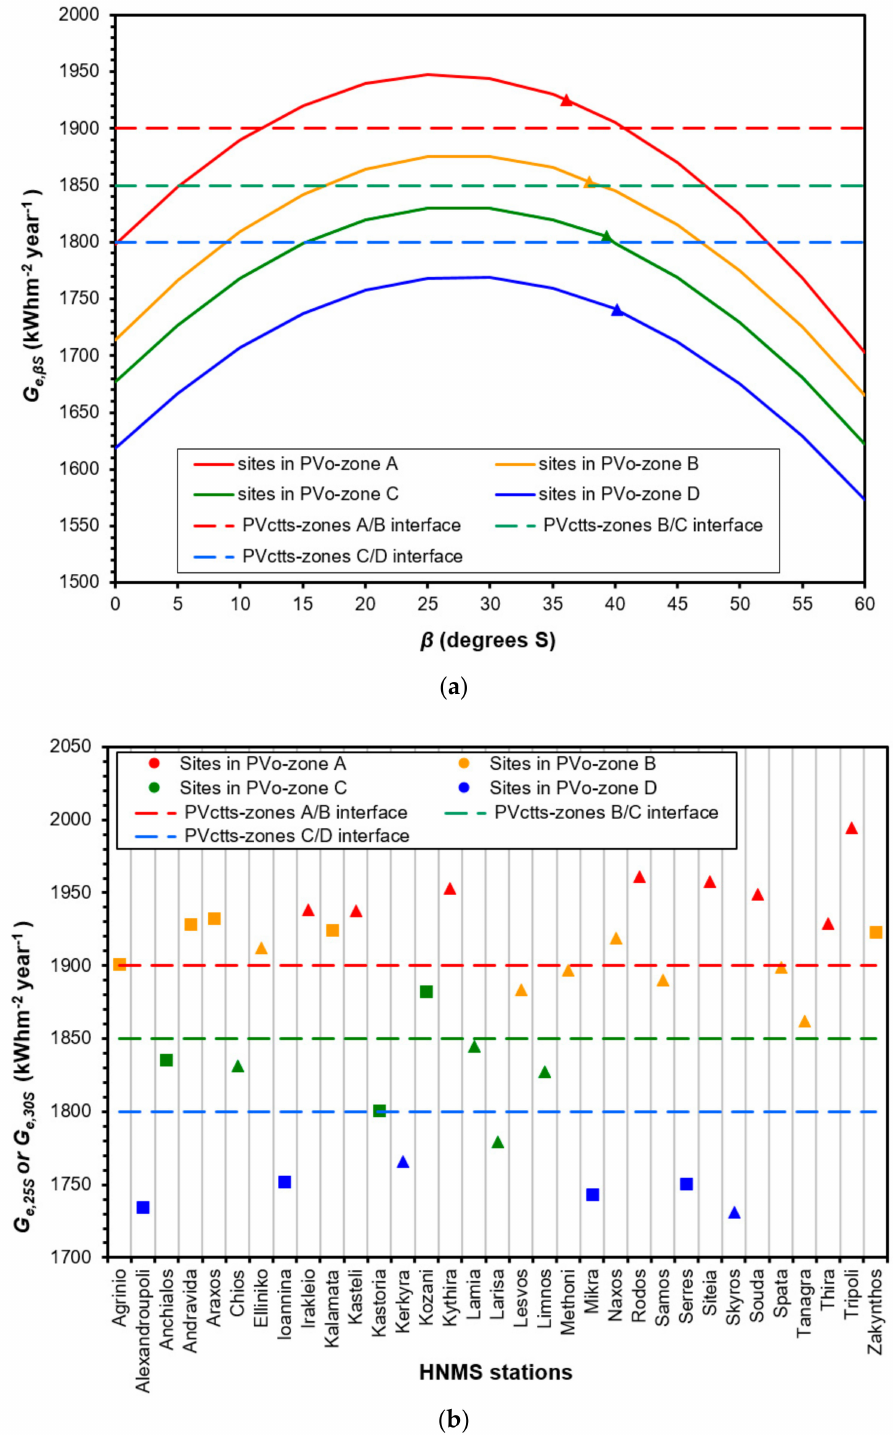
Figure 5. ( a ) Solar energy yield per year on a south-facing plane with an inclination of 0–60 ◦ in steps of 5 ◦ . The inclination of the averaged ϕ ◦ is presented with triangles. The energy shown is the annual sum averaged for all sites belonging to the same PV 0 zone. ( b ) Solar energy yield per year on a south-facing plane with an optimum inclination of 25 ◦ (triangles) or 30 ◦ (squares), depending on site. Sites are in alphabetical order and colored according to the PV 0 zone. Solar irradiation data points laying on the threshold lines are categorized into the zone their center is closer to. In both graphs, the PV ccts zone interfaces (straight, dashed lines) are